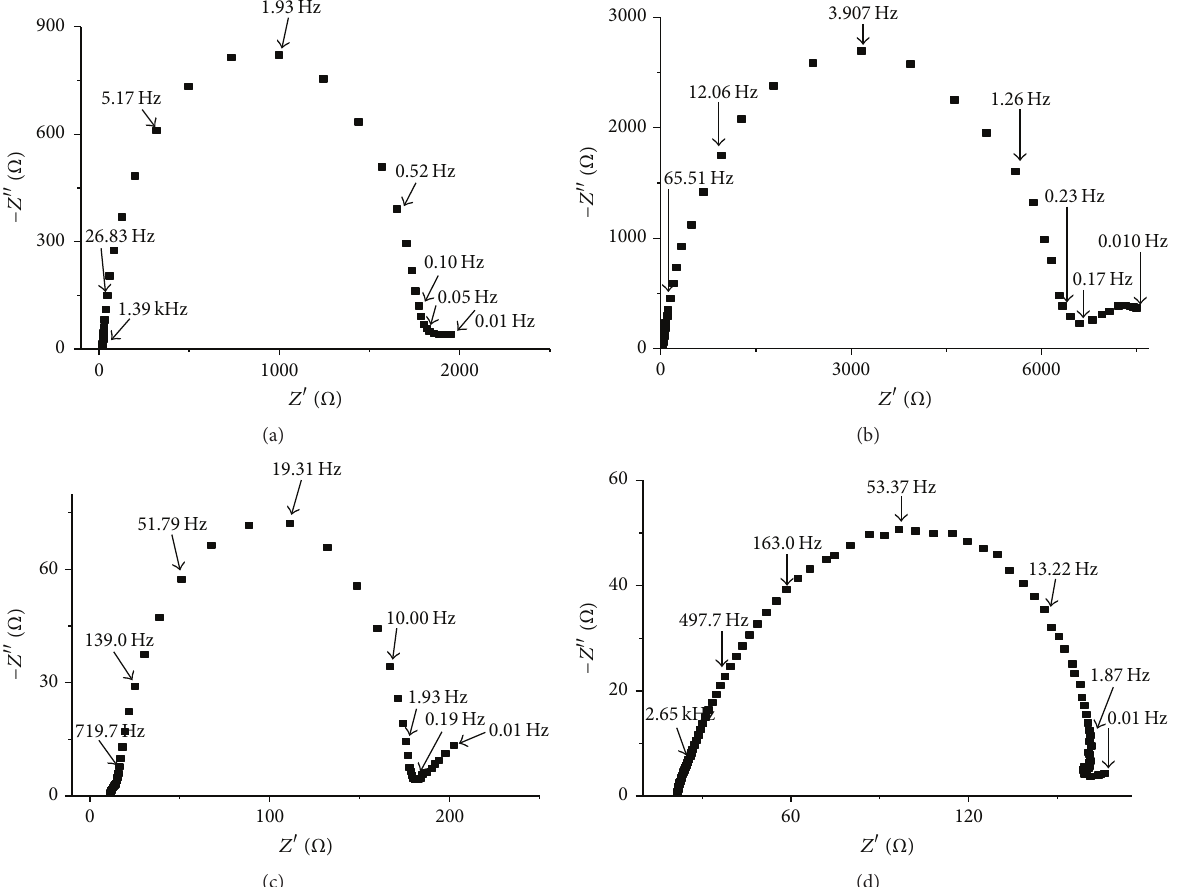
Figure 7: Nyquist plots for the devices fabricated with (a) ZnO alone, (b) SnO 2 /ZnO with electrolyte X and (c) ZnO alone, and (d) SnO 2 /ZnO with electrolyte Y under dark and forward bias at − 0.58 V.